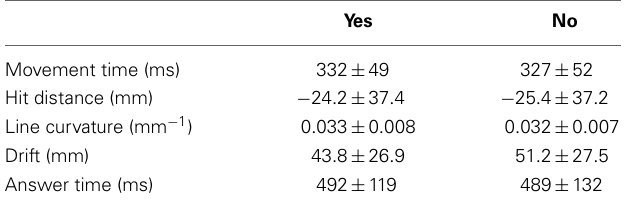
Table 1 | Kinematic for all deviations divided into the two categories of subjective